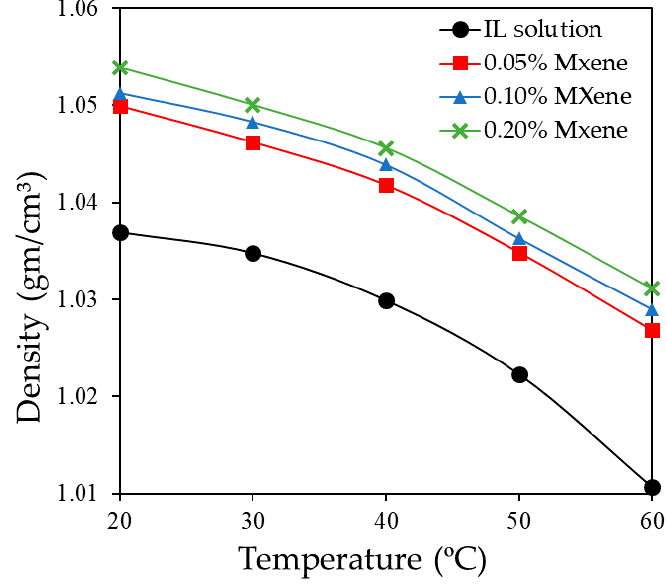
Figure 12. Density curve of IL+ water and IL + water/Ti 3 C 2.